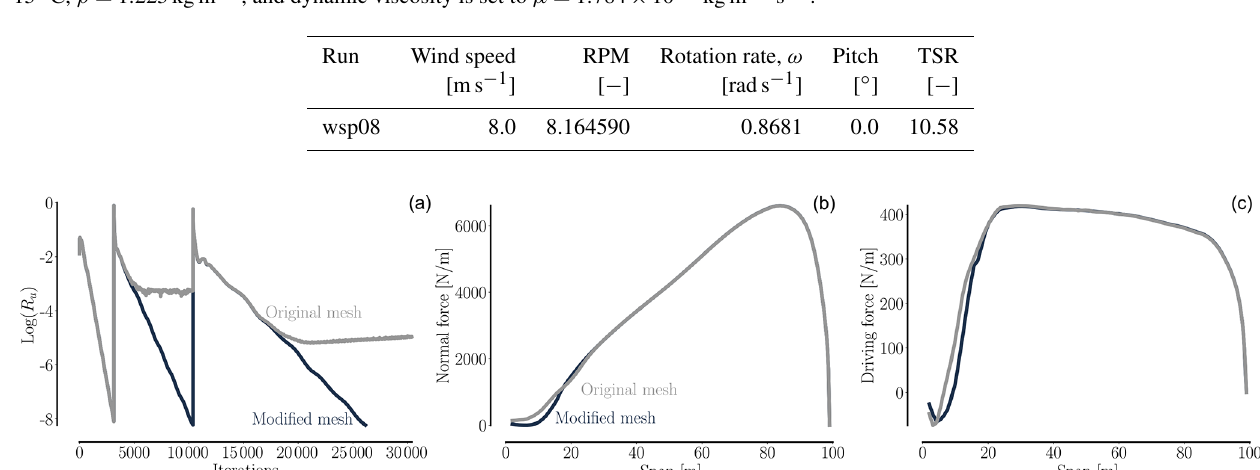
Table 2. Operational conditions for the simulations used in both analysis and optimization. Density is set to the density of air at sea level and 15 ◦ C, ρ = 1 . 225kgm − 3 , and dynamic viscosity is set to µ = 1 . 784 × 10 − 5 kgm − 1 s − 1 .